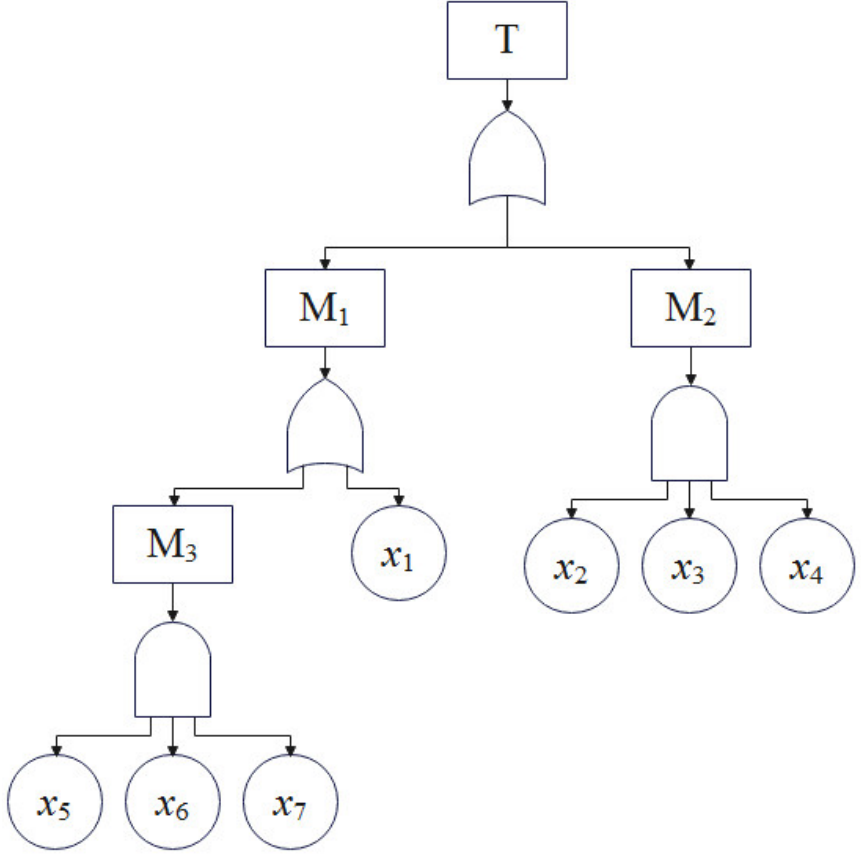
Figure 5. Fault tree model for blocking of horizontal drainage pipe of Metro Tunnel.